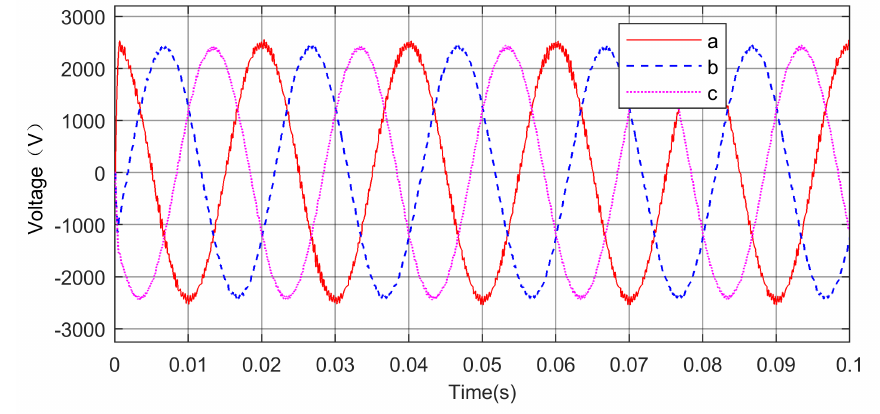
Figure 8. Output three-phase voltage diagram under case 1.